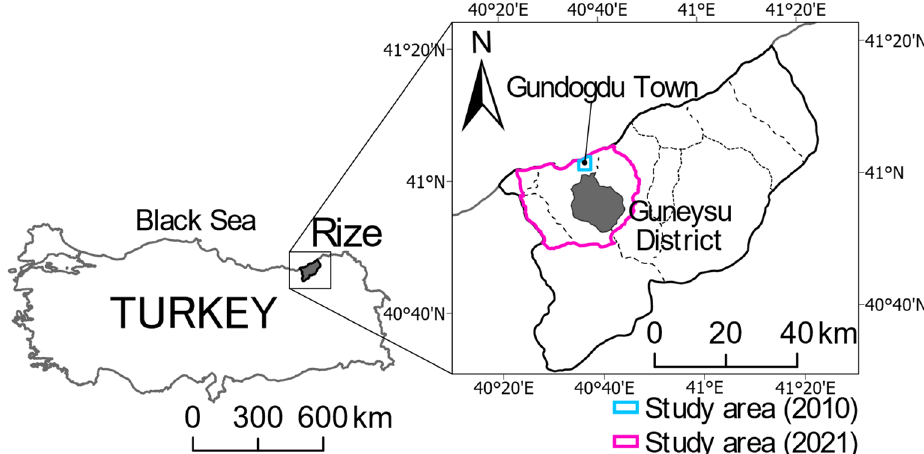
Figure 1. Location map of study area.